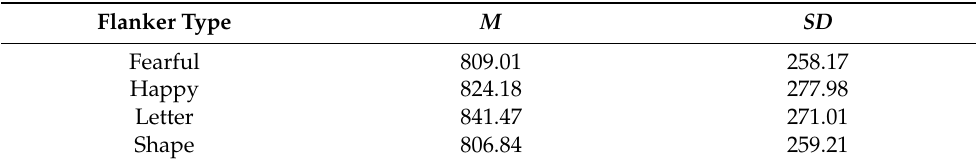
Table 7. Estimates of Reaction Times for correct rejection (before log-transformed) for each flanker